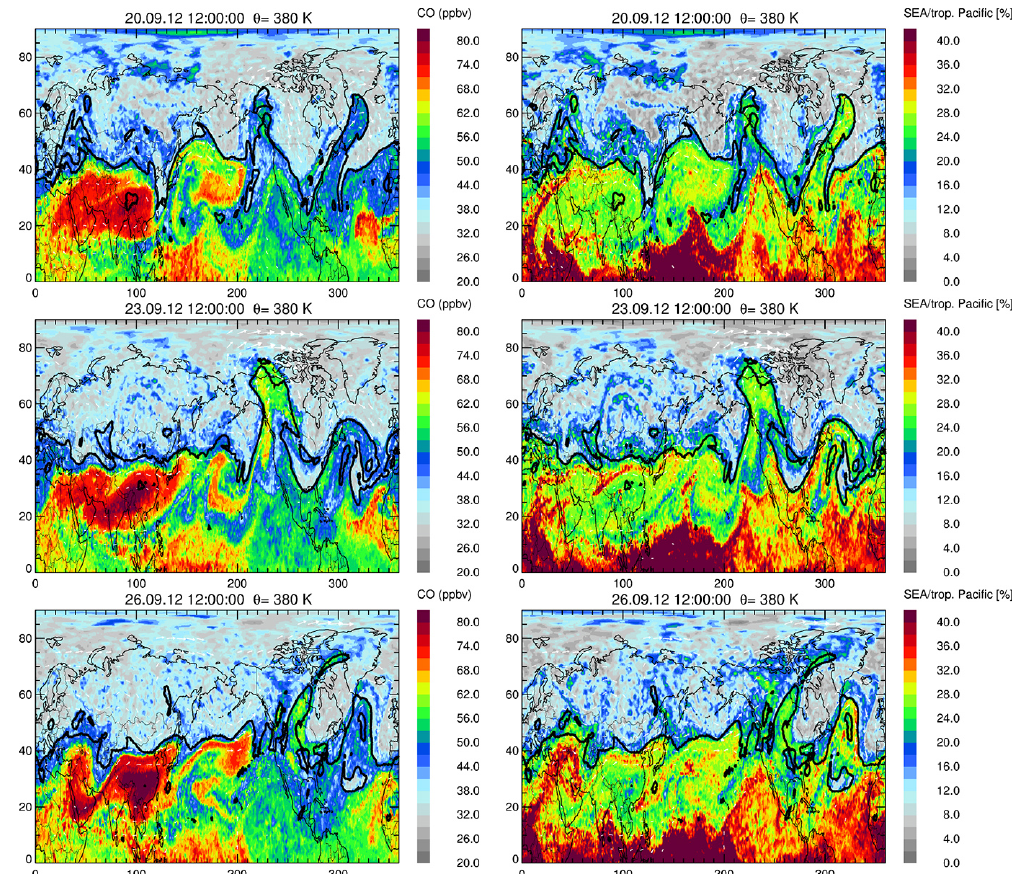
Figure 4. The same as Fig. 3, but for simulated CO (left) and the fraction of air originating in southeast Asia/tropical Pacific